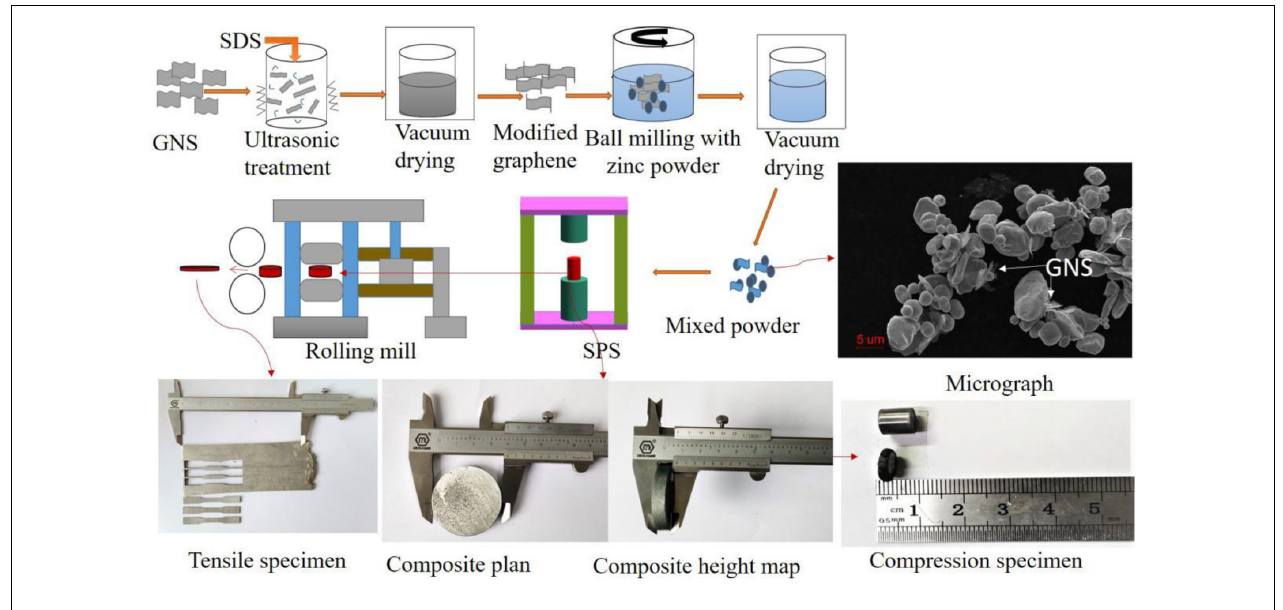
FIGURE 1 | Preparation of GNS/Zn composite